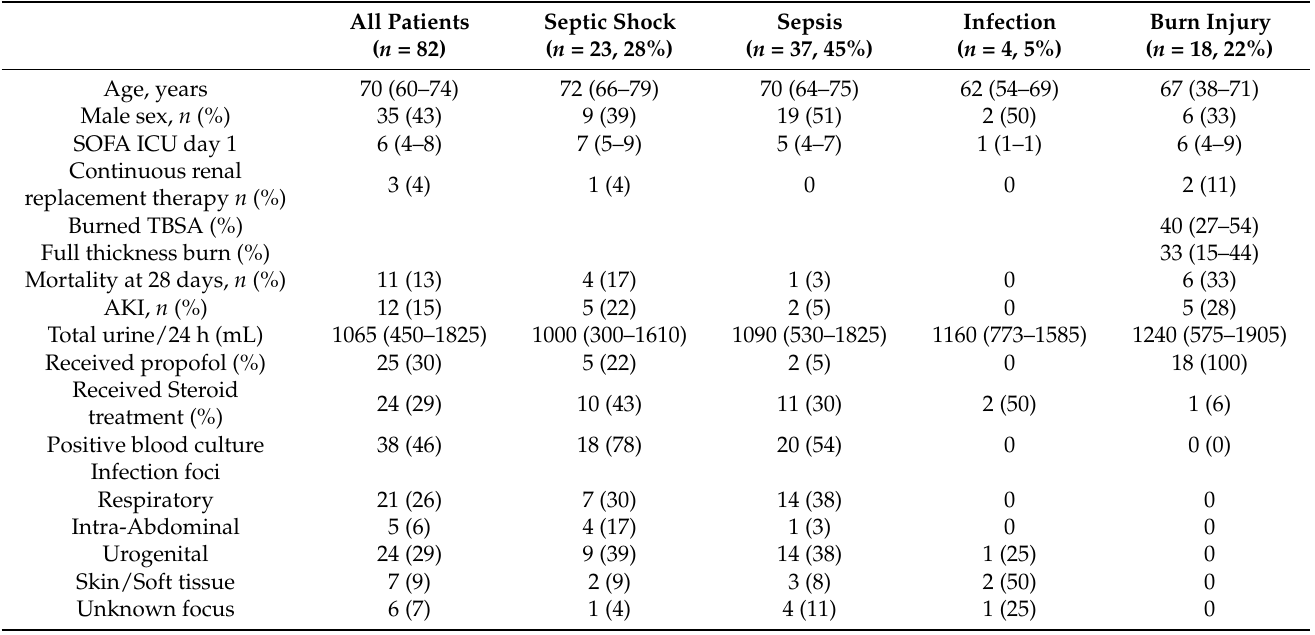
Table 1. Patient demographics and clinical parameters. Data are presented as a median (IQR) unless otherwise